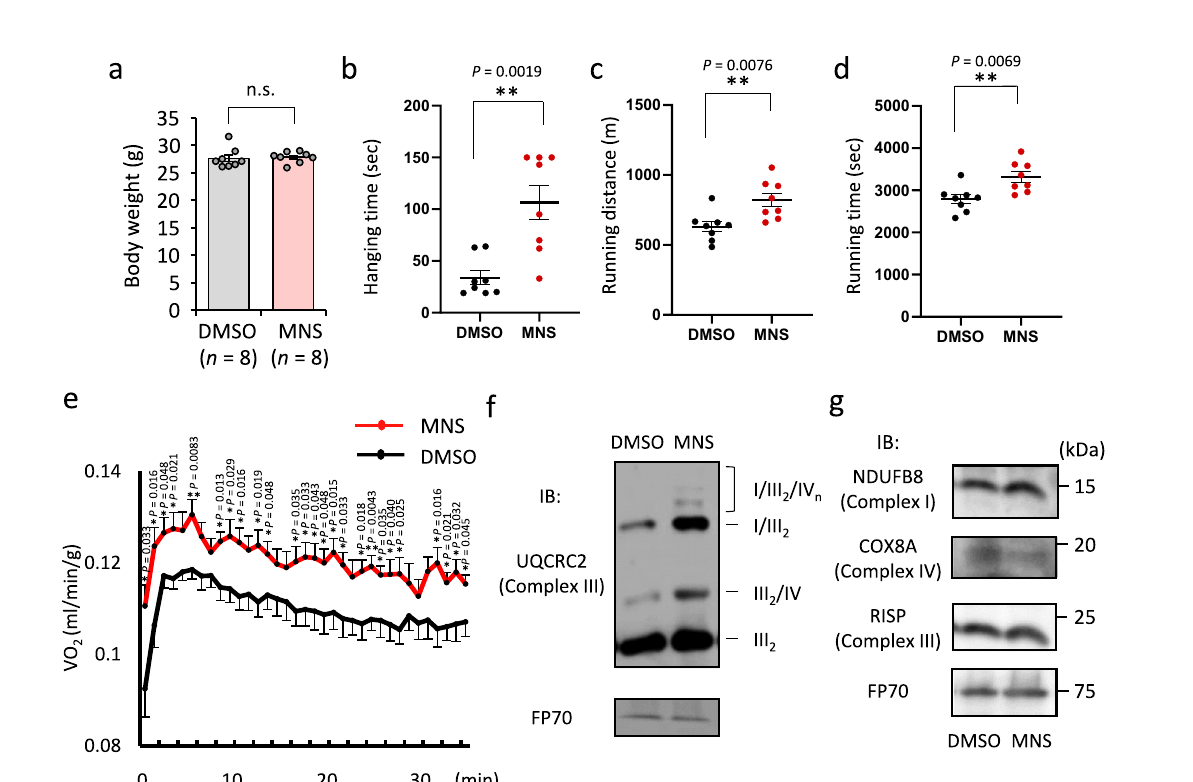
Fig. 5 | Inhibition of Syk expression increases mitochondrial respiratory chain supercomplex assembly in C2C12 myoblastic cells. a Knockdown of Syk expression in C2C12 cells transfected with its speci fi c siRNAs (siSyk #1 and #2) evaluated by qRT-PCR. Indicated siRNAs (100pM each) were used. Data are pre- sented as means±SE of three biologically independent samples. *** P <0.001; two- wayANOVA. b Immunoblotting(IB)formitochondrialprotein expressionin C2C12 cells transfected with indicated siRNAs (100pM each), probed with antibodies againstdistinctrespiratorycomplexes. β -Actin wasanalyzedasaninternalcontrol. c Imaging cytometer-based quanti fi cation of cFRET/donor ratios for C2C12 cells stably co-expressing NDUFB8-AcGFP and COX8A-DsRed-Monomer transfected withindicatedsiRNAs.Dataarepresentedasmeans±SEfrom12wells.*** P <0.001;